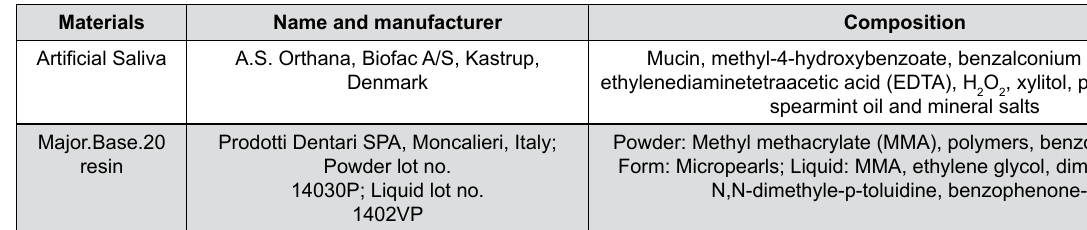
Figure 1- Composition of heat cured acrylic resin and artificial